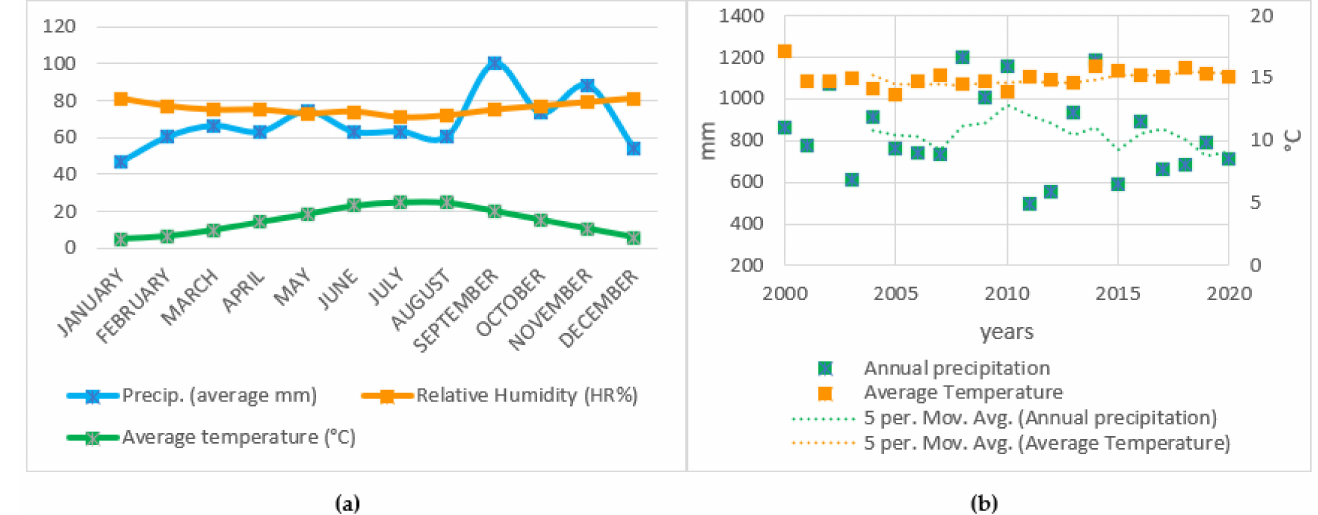
Figure 5. Arpav data elaboration: ( a ) monthly division for the 2000–2020 period of average precipita- tion (mm) in blue, average relative humidity (HR%) in orange, average temperature ( ◦ C) in green; ( b ) average annual precipitation and mean temperature from 2000 to 2020 with five year moving averages (dot lines).